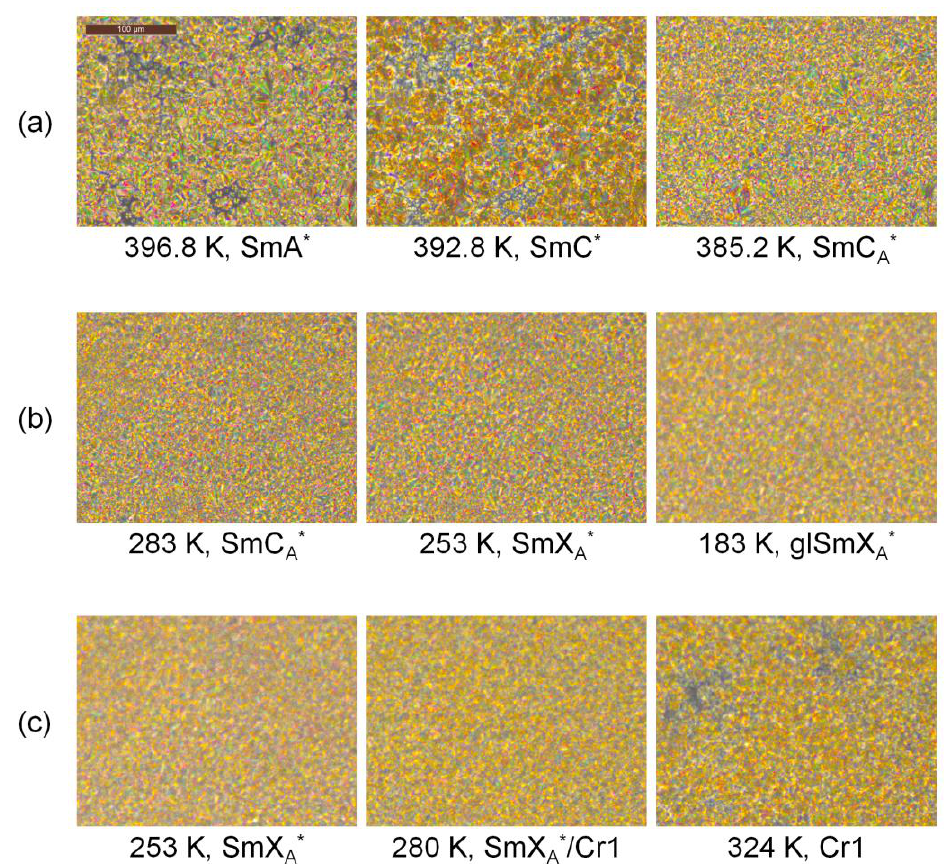
Figure 3. POM textures registered during cooling at 2 K/min ( a ), cooling at 15 K/min ( b ) and subsequent heating at 15 K/min ( c ). The scale bar refers to 100 μm.